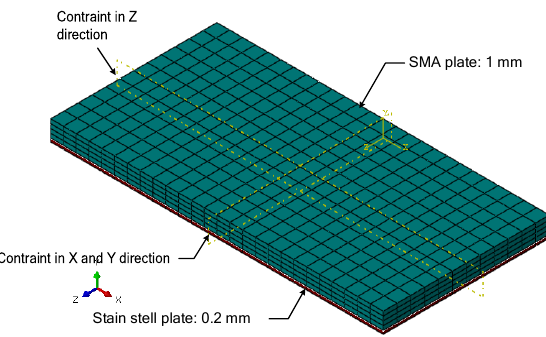
Figure 9. Three-dimensional structure mesh of SMA.